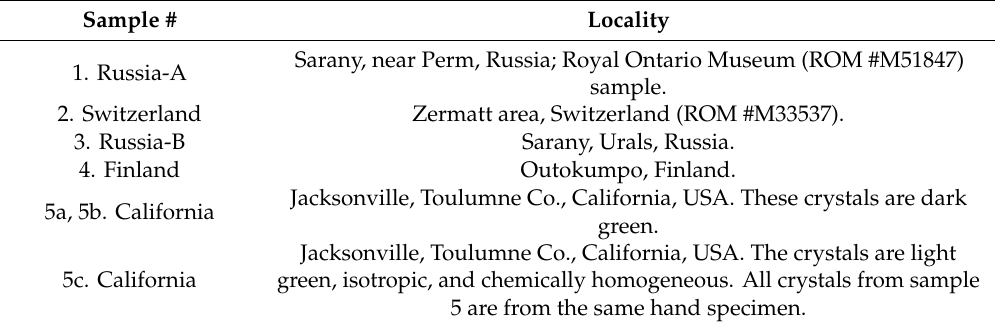
Table 1. Localities of the uvarovite samples † used in this study.